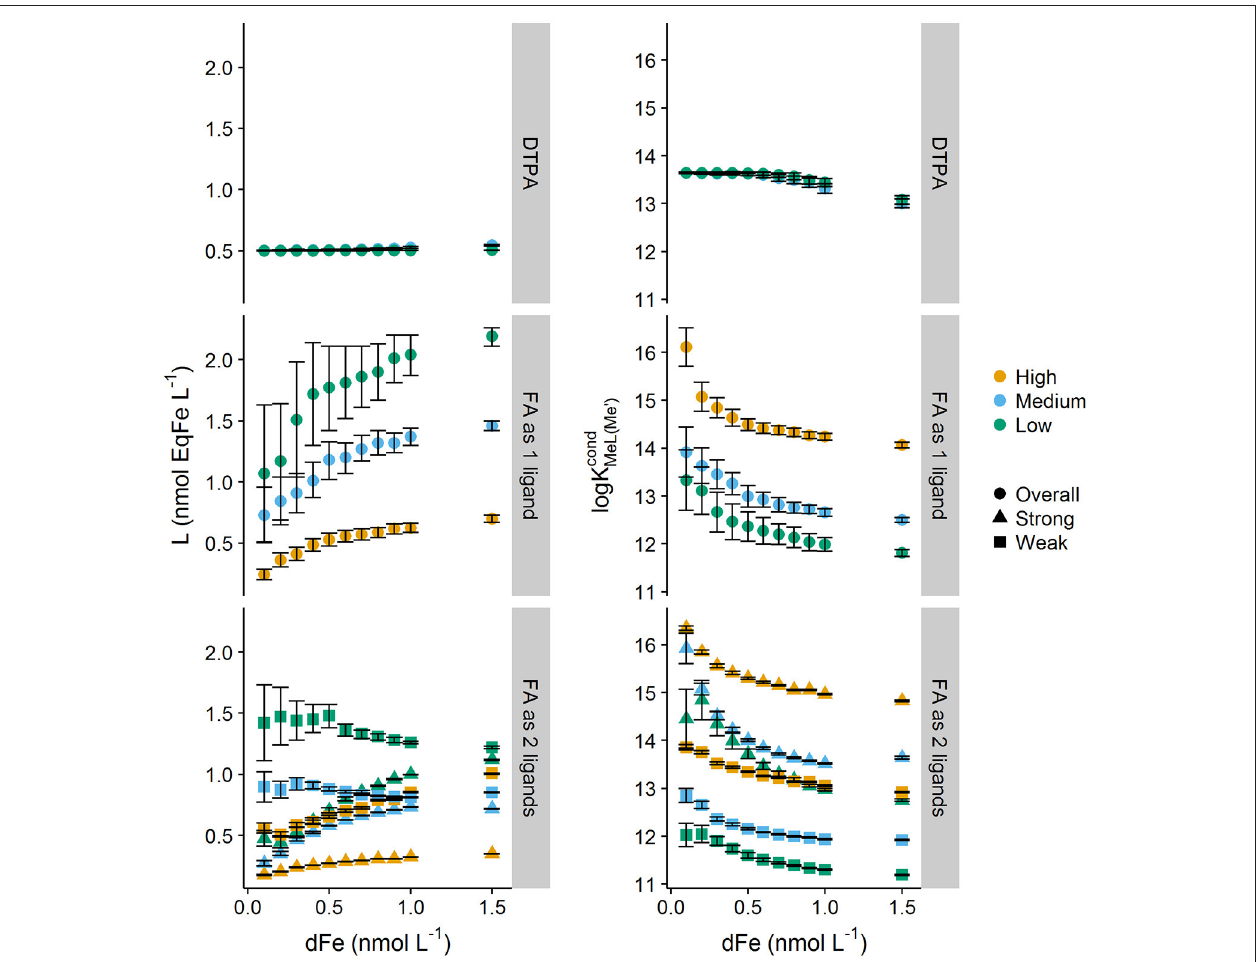
FIGURE 2 | Ligand and conditional stability quotients obtained from simulated forward titrations with different starting dissolved iron concentrations (0.1–1.5 nmol kg − 1 ) of diethylenetriaminepentaacetic acid (DTPA, [ L ] = 0.5nM, K cond FeDTPA ( Fe ′ ) = 13.6) and a heterogeneous mix of binding sites described by the NICA model of fulvic acid (DOC = 64 µ mol L − 1 ) interpreted as only one ligand, and as two ligands. Three different added ligand concentrations were used to simulate titrations applying a high, medium and low detection window. Symbols indicate apparent class of ligand strength, where overall is the ligand class obtained when transformations only considered one ligand class to be present, and strong and weak differentiate the ligand classes for the two ligand transformations. Error bars represent 95% confidence intervals.